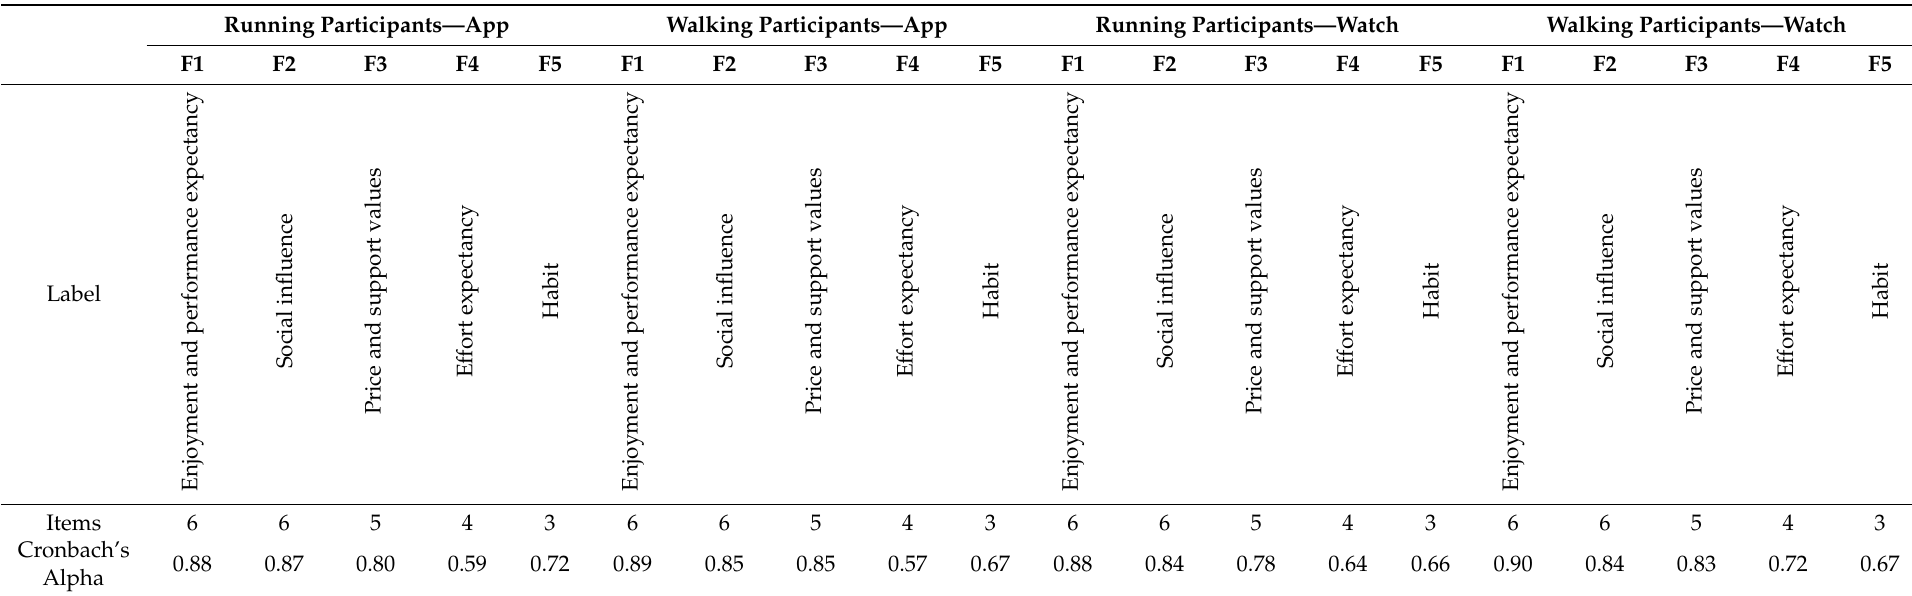
Table 3. Reliability of scale to measure motivation to use applications and sports watches among running and walking participants. Running Participants—App Walking